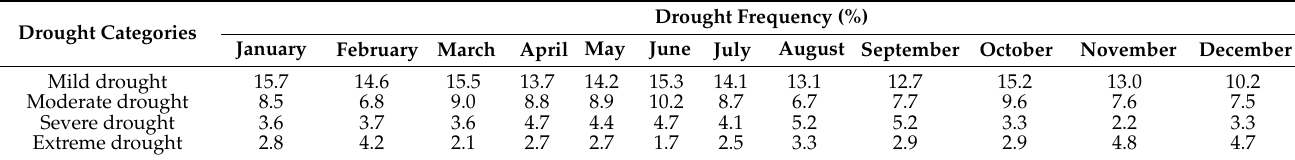
Figure 7. Temporal variation of monthly SPI on a 1-month time scale in HSDC, 2000–2019. Table 1. Frequency of drought of varying severity in HSDC at the monthly